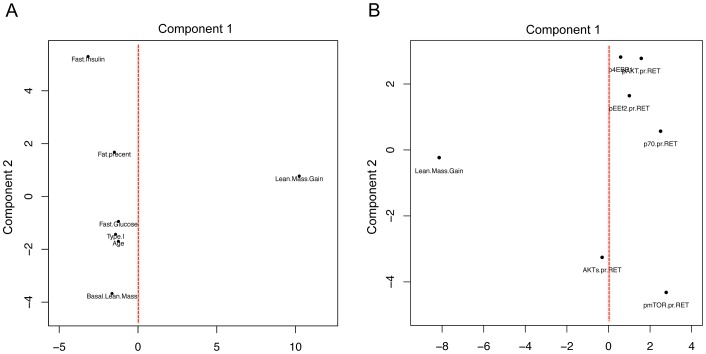
Using principal component analysis to evaluate the relationship between physiological and acute protein signaling events to RET induced gains in lean mass.A) Change in lean mass following 20 wk RET and a number of physiological parameters which demonstrated the most variance were scaled to a common value and plotted using principal component analysis in R. Principal component (PC) 1 captured the major variance in lean mass gains across subjects however none of the commonly postulated physiological parameters varied with lean mass (linear regression analysis demonstrated no significant association also). PC2, the second largest proportion of independent variance also demonstrated no association between factors such as fiber type or age and gains in lean mass. B) Phospho-protein signaling 2 hr after a combined exercise and nutrition acute intervention (to promote anabolic signaling) were scaled and plotted with change in lean mass following 20 wk RET. Again these acute signaling events shared little common variance in either PC1 or PC2 with changes in lean mass with 20 wk RET.